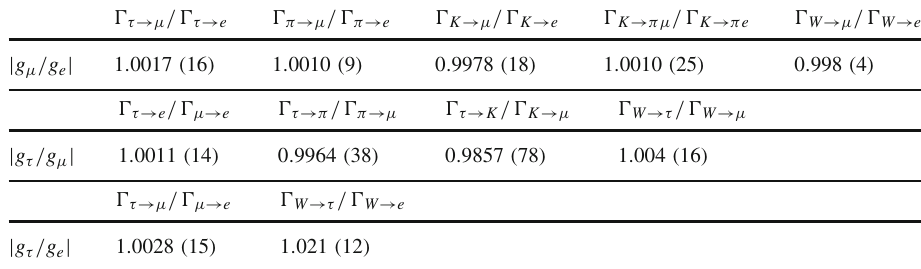
Table 1 Experimental determinations of the ratios g (cid:2) / g (cid:2) (cid:5) [334,383,387,388]